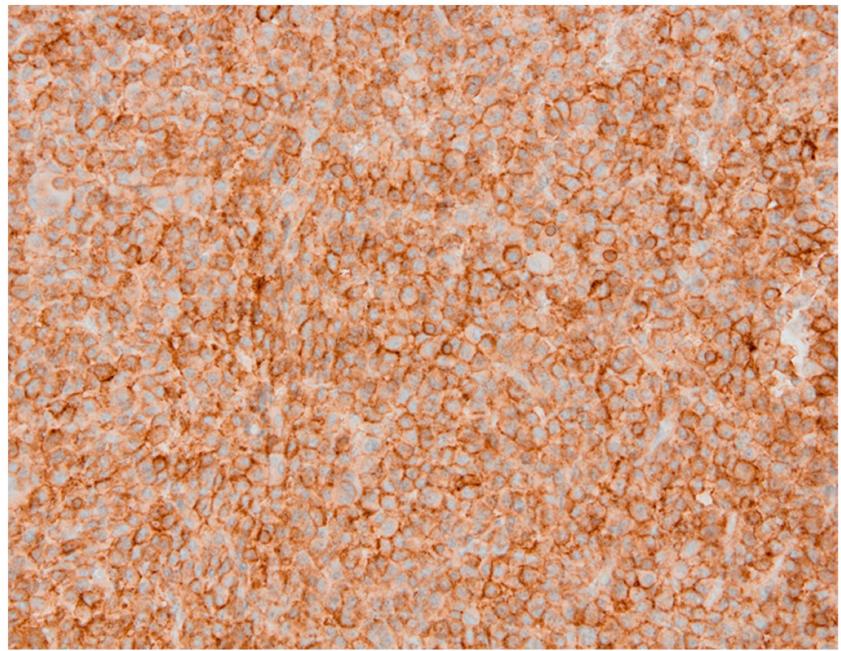
Figure 7. For SSTR5—presented here—the IRS of 8 is higher than that for SSTR2 (patient